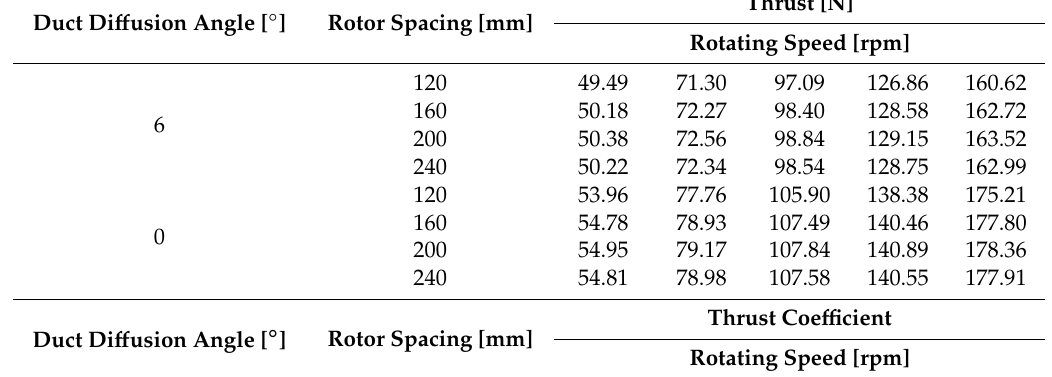
Table 2. Thrust, thrust coe ffi cient, and power coe ffi cient of all the counter-rotating ducted fan cases. Duct Di ff usion Angle [ ◦ ] Rotor Spacing [mm]